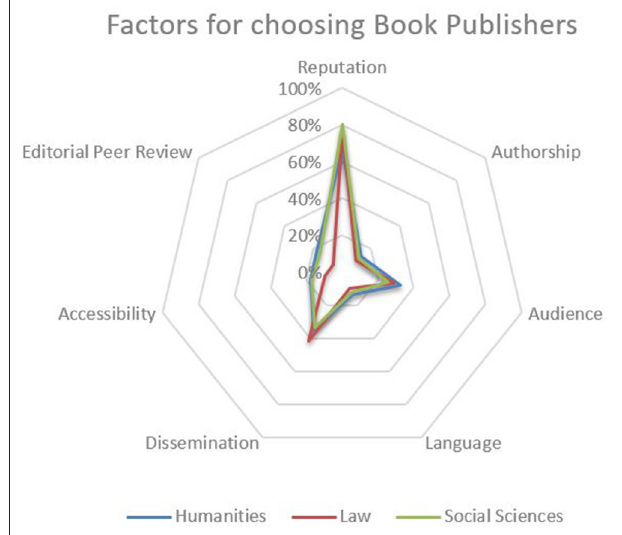
FIGURE 6 | Factors for choosing book